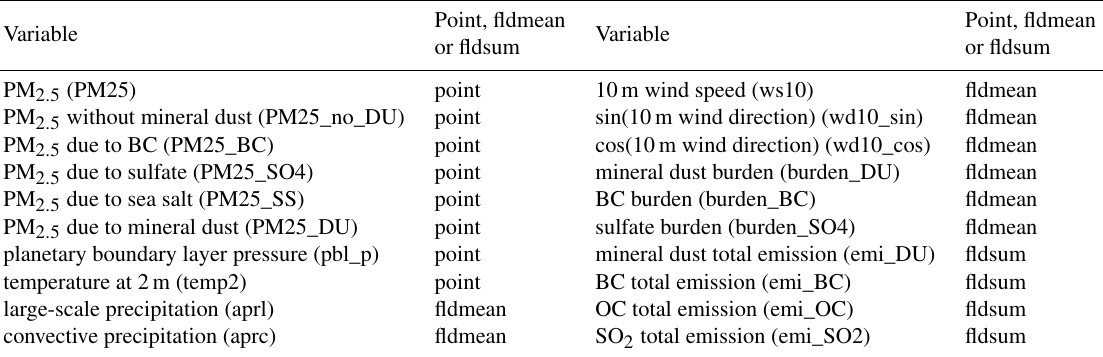
Table 3. Input features used in the random forest fitting. The corresponding abbreviations used in Figs. 1 and 2 are written in brackets. Feature data are retrieved only for one grid box (point) or over a larger area (24–34 ◦ N, 72–82 ◦ W). For the larger area, we calculated either the area-weighted mean value (fldmean) or the sum over the whole area (fldsum). The burden indicates vertically integrated concentration